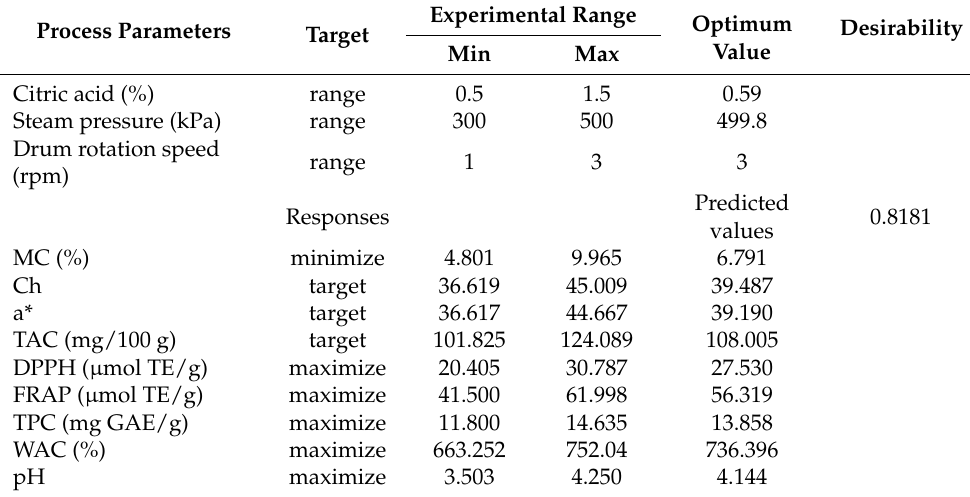
Table 5. Optimum drum drying parameters and responses for the